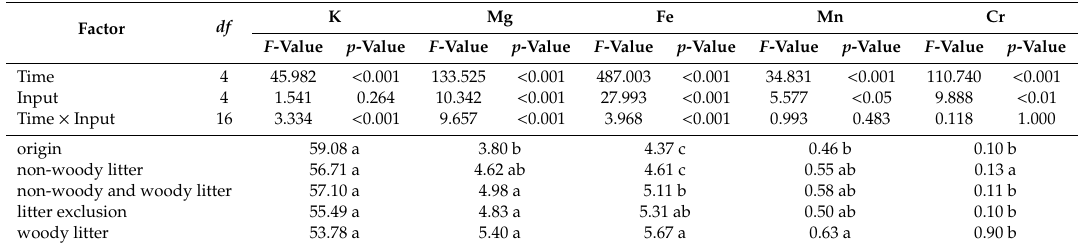
Table 6. E ff ects of time, debris input and their interaction on metals concentration of sediment tested by repeated-measure ANOVA analyses.